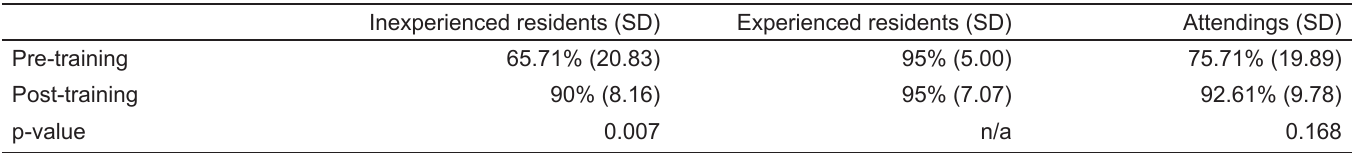
Table 2. ACEP obstetrical ultrasound test